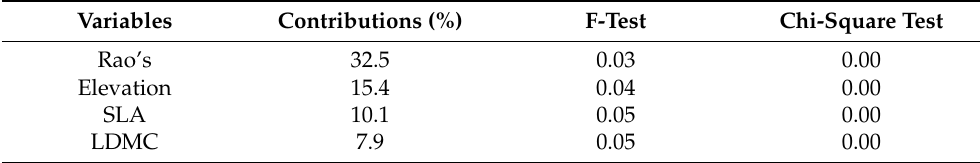
Table 3. Contributions of Rao’s, elevation, SLA, and LDMC on biomass in